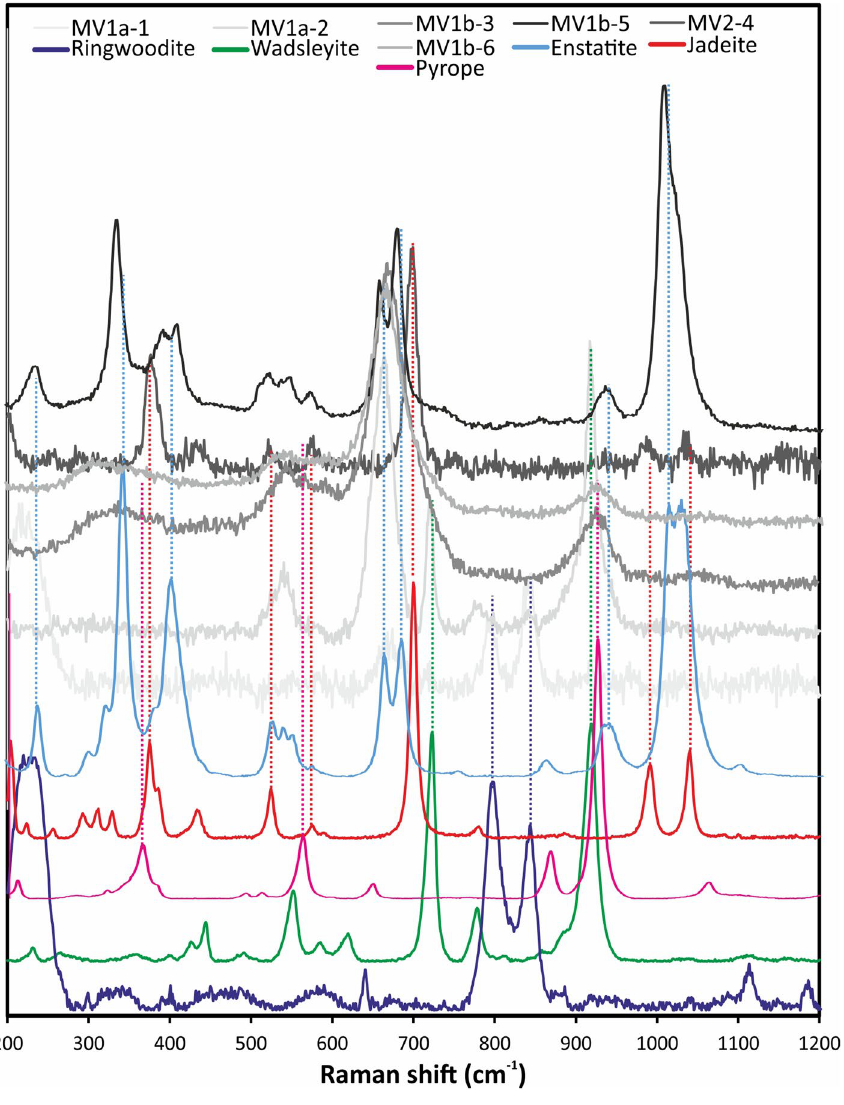
Figure 5. Selected Raman spectra of HP minerals in Kakowa compared to reference spectra for ringwoodite (RRUFF R070079), wadsleyite (RRUFF R090004), jadeite (RRUFF R050220.2), pyrope (RRUFF R080060), and enstatite (RRUFF